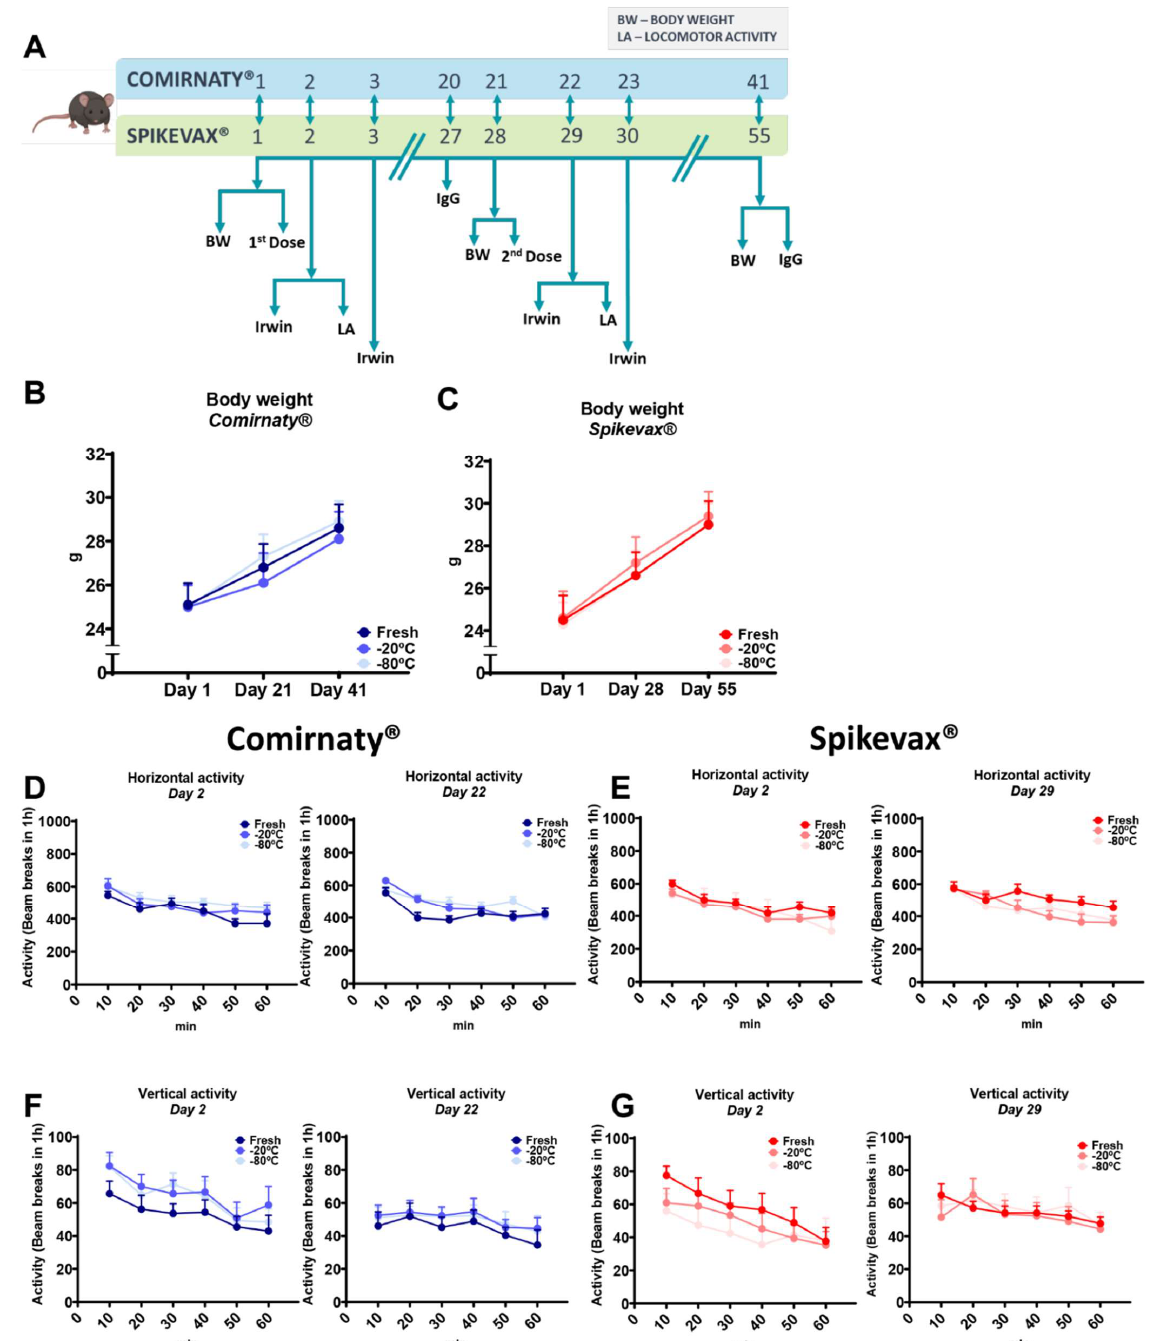
Figure 2. Different handling and re-freezing conditions of reconstituted Comirnaty ® and Spikevax ® COVID 19 vaccines did not affect behavioral and physiological measurements in mice. ( A ) Timeline of the experimental sequence in mice. ( B , C ) Bodyweight (BW) was measured three times during the procedure, at days 1, 21, and 41 for Comirnaty ® ( B ) and at days 1, 28, and 55 for Spikevax ® ( C ). ( D – G ) Locomotor activity measured in actimetry boxes. Beam breaks measured the horizontal and vertical activity for 60 min. Locomotor activity was assessed two times, precisely 24 h after each vaccine administration with Comirnaty ® at days 2 (( D )-left and ( F )-left) and 22 (( D )-right and ( F )-right) and Spikevax ® at days 2 (( E )-left and ( G )-left) and 29 (( E )-right and ( G )-right). All data are expressed in mean ± SEM ( n = 10 for each group). Statistical details are included in Table